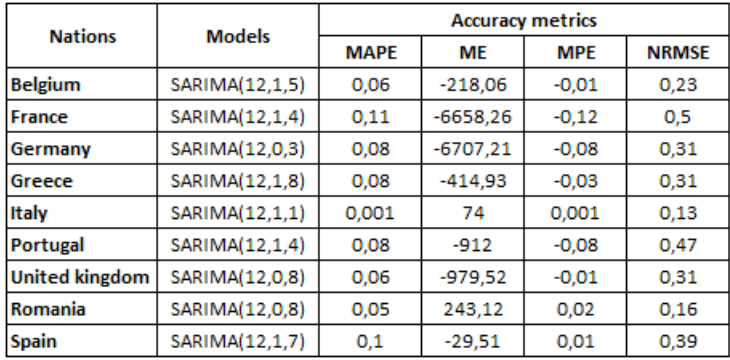
Table 7. Models and accuracy metrics of the analysed